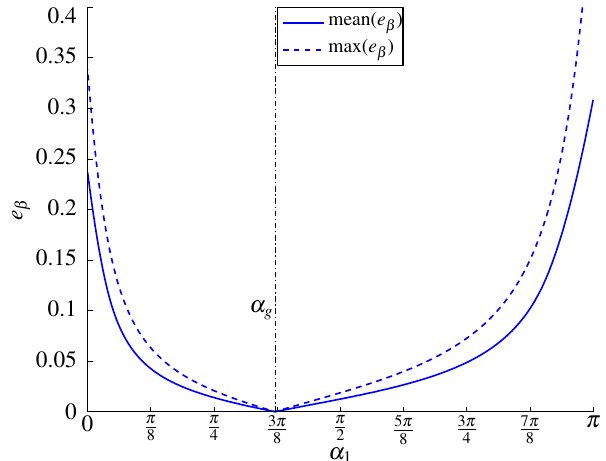
Figure 6. Mean and maximum error in the interval α 0 ≤ α ≤ α 2 as a function of α 1 for l 1 / r = 5.